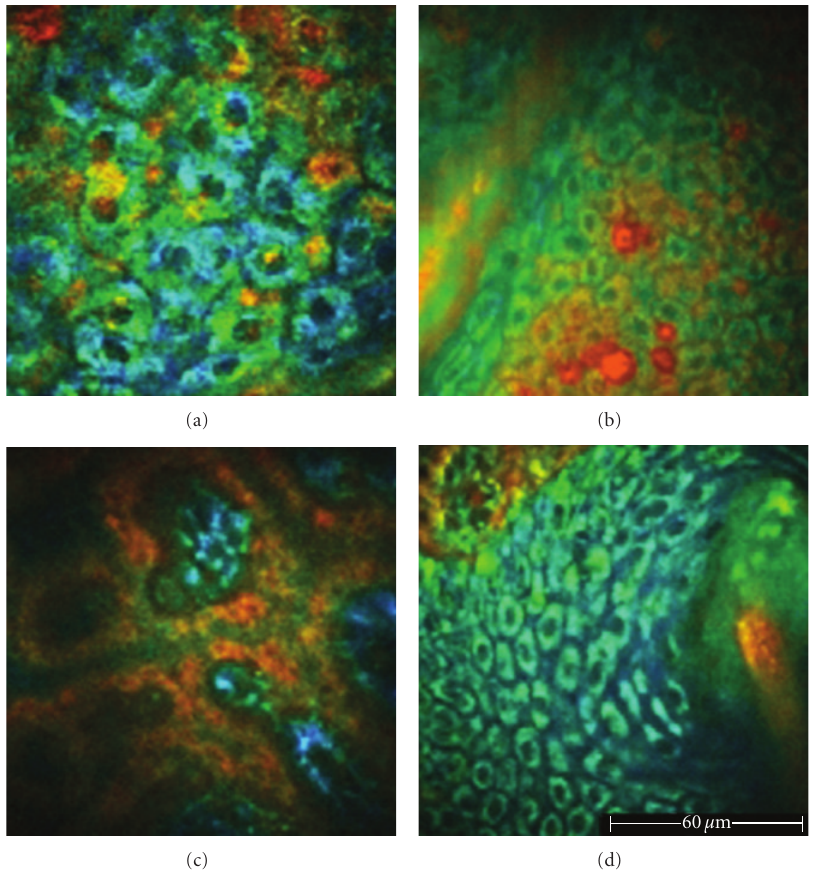
Figure 5: FLIM images of healthy skin acquired in vivo by the Imperial College FLIM system incorporated in the DermaInspect . (a) 760 nm excitation wavelength. In the false-colour images, keratinocytes appear green-blue, showing a longer fluorescence lifetime with respect to melanin aggregates corresponding to yellow-red areas with a shorter lifetime value. (b) 760 nm excitation wavelength. Keratinocytes of the basal layer appearing yellow-red because of the presence of pigmentation. (c) 760 nm excitation wavelength. Dermal papillae surrounded by pigmented keratinocytes and melanocytes with low FLIM values. (d) 760 nm excitation wavelength. A hair-follicle with bluish perifollicular cells showing a shorter